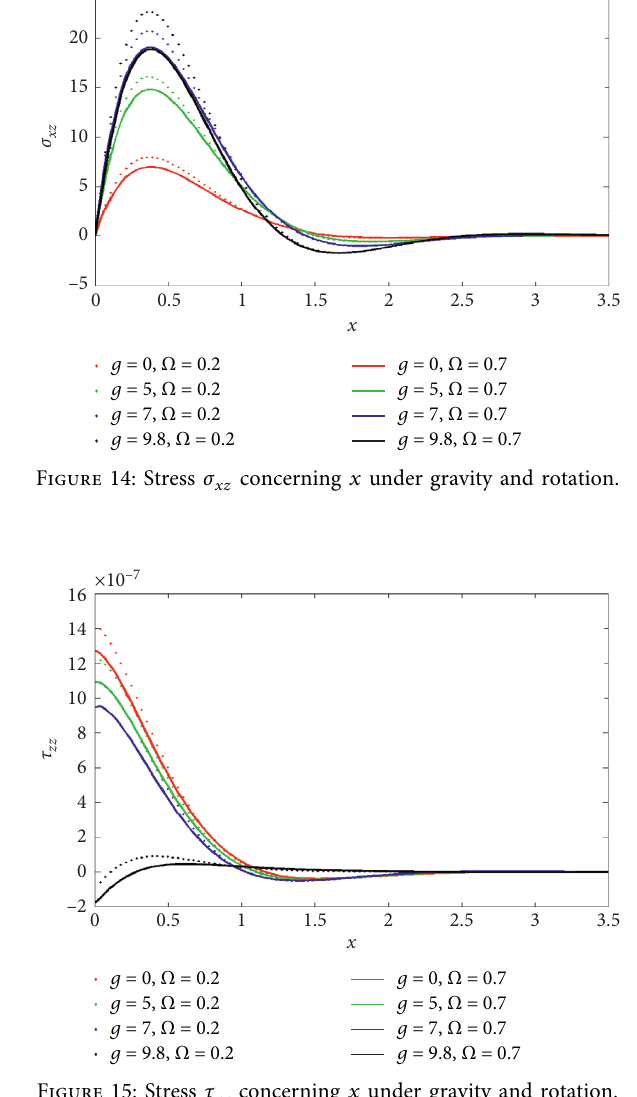
x under gravity and